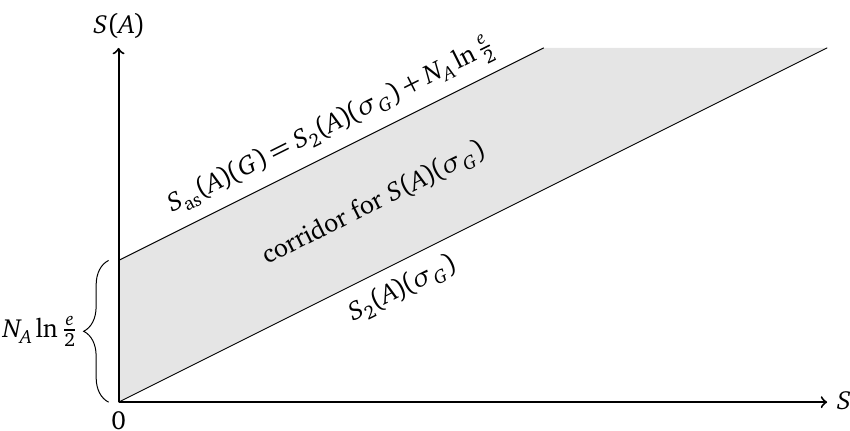
Figure 1: Bounding corridor for von Neumann entropy of Gaussian states. We show how the von Neumann entropy S ( A )( ρ ) of a Gaussian state σ bounded from below by the Rényi entropy S ( A )( G ) entropy S as